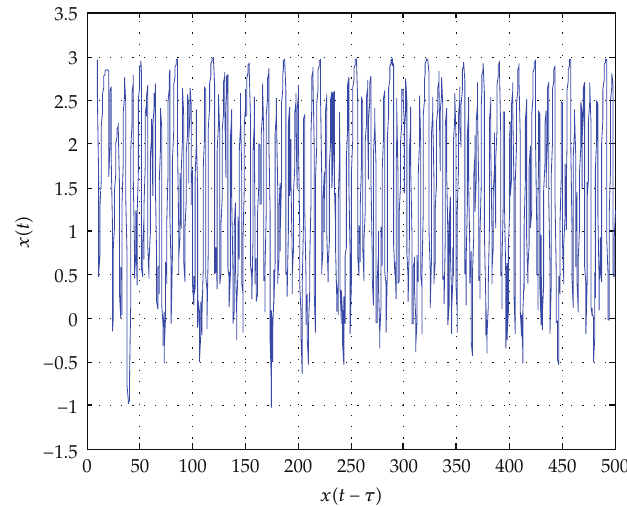
Figure 6: Time dependence of the state variables x (cid:2) t (cid:3) in the system (cid:2) 3.1 (cid:3)